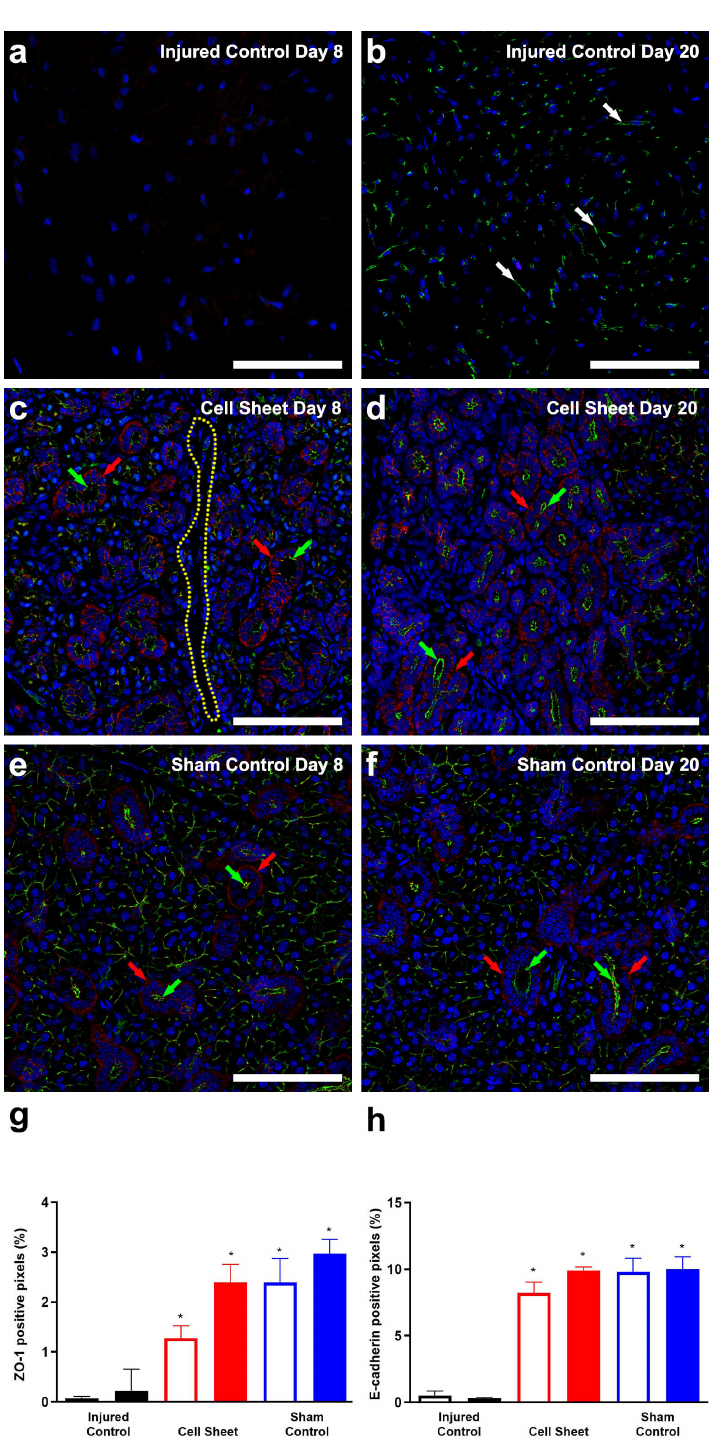
Figure 3. Cell sheets promote epithelial polarization: injured SMG ( a , b ); injured SMG treated with cell sheets ( c , d ); and sham controls ( e , f ). Tissue samples were incubated with rabbit anti-ZO-1 ( a – f ) (green) and mouse anti-E-cadherin ( a – f ) (red) antibodies and analyzed using a Zeiss LSM 700 confocal microscope, with data representative of results from five experiments and white bars indicating 100 µ m. Positive areas of ZO-1 ( g ) and E-cadherin ( h ) fluorescence were captured using ImageJ software. Data are expressed as means ± SD of results from five independent experiments, where statistical significance was assessed by one-way ANOVA ( p < 0.05) and Dunnett’s post-hoc test for multiple comparisons to injured controls (open bars: Day 8; closed bars: Day 20); * significant di ff erence from injured controls. White / green and red arrows indicate ZO-1 and E-cadherin expression, respectively. Finally, a yellow dotted line indicates a lack of ZO-1 and E-cadherin